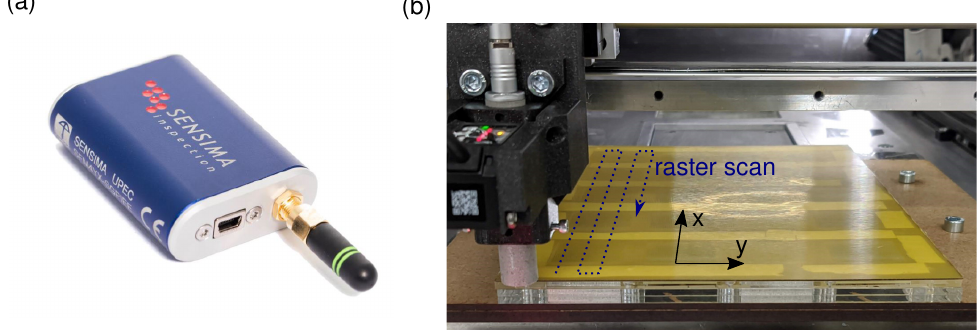
Figure 2. Measurement setup used for ECT. ( a ) Standard UPEC tester of Sensima Inspection SARL. ( b ) X-Y table laboratory test